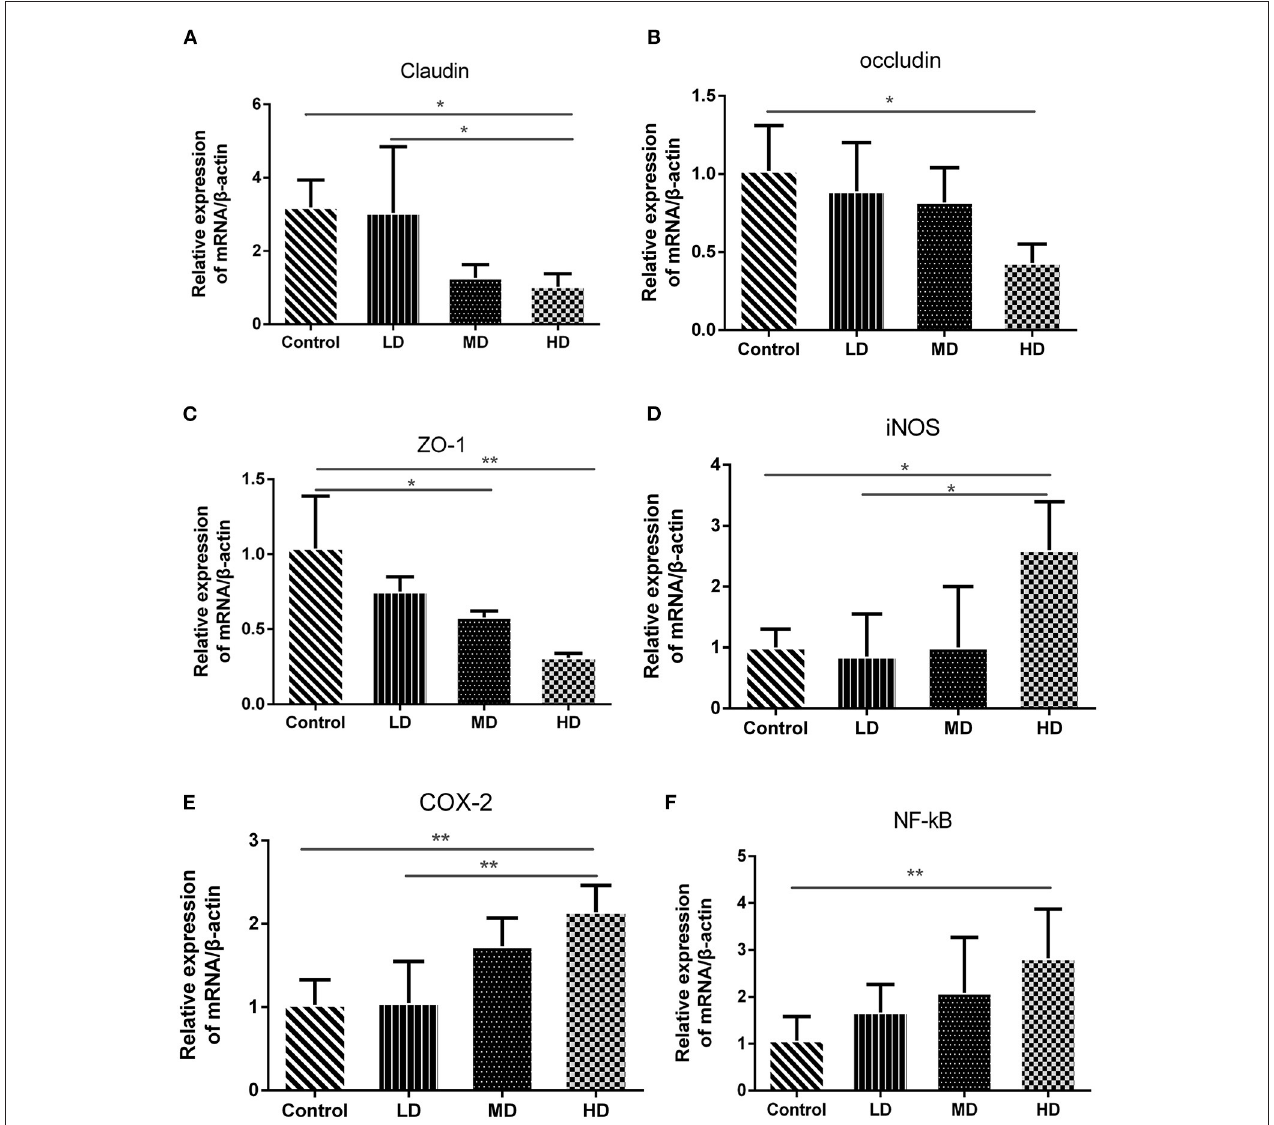
FIGURE 6 | Gene expression levels determined by RT-PCR. The mRNA level of (A) Claudin, (B) Occludin, (C) ZO-1, (D) COX-2, (E) iNOS, and (F) NF-kB. Data are presented as mean ± SD, and * p < 0.05, ** p <